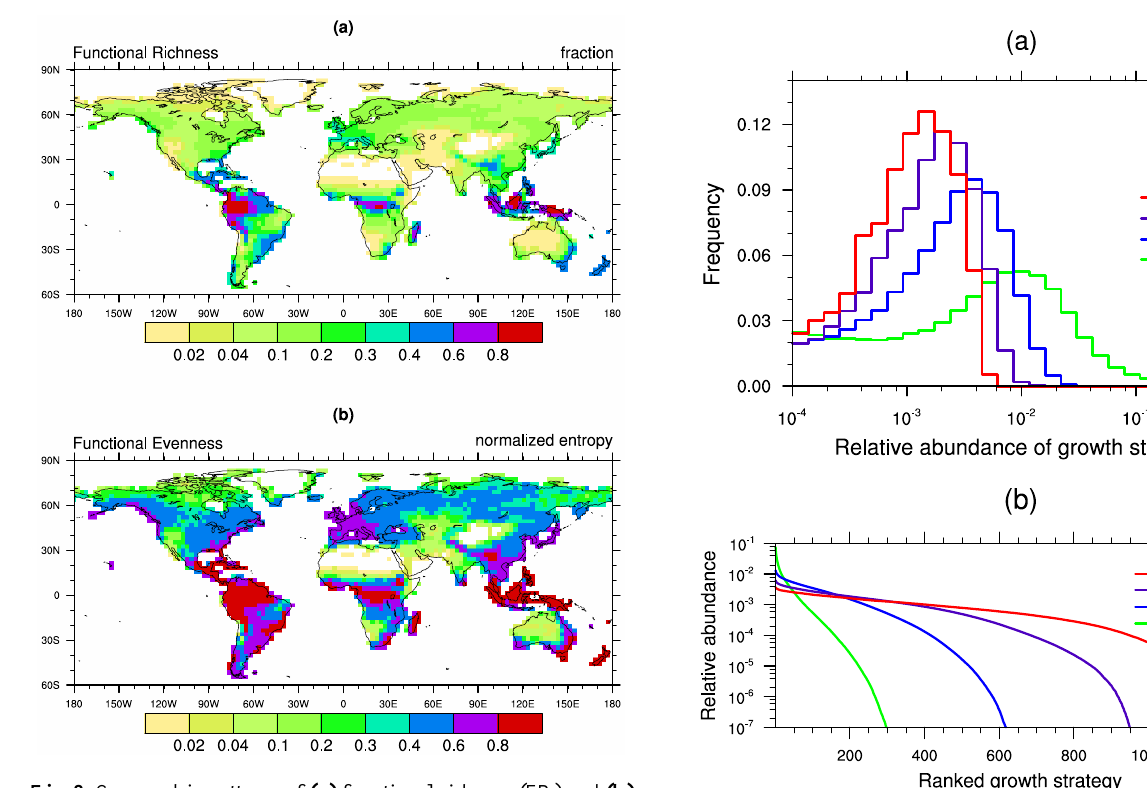
Fig. 8. Geographic patterns of (a) functional richness (FR) and (b) functional evenness (FE) as simulated by JeDi-DGVM.